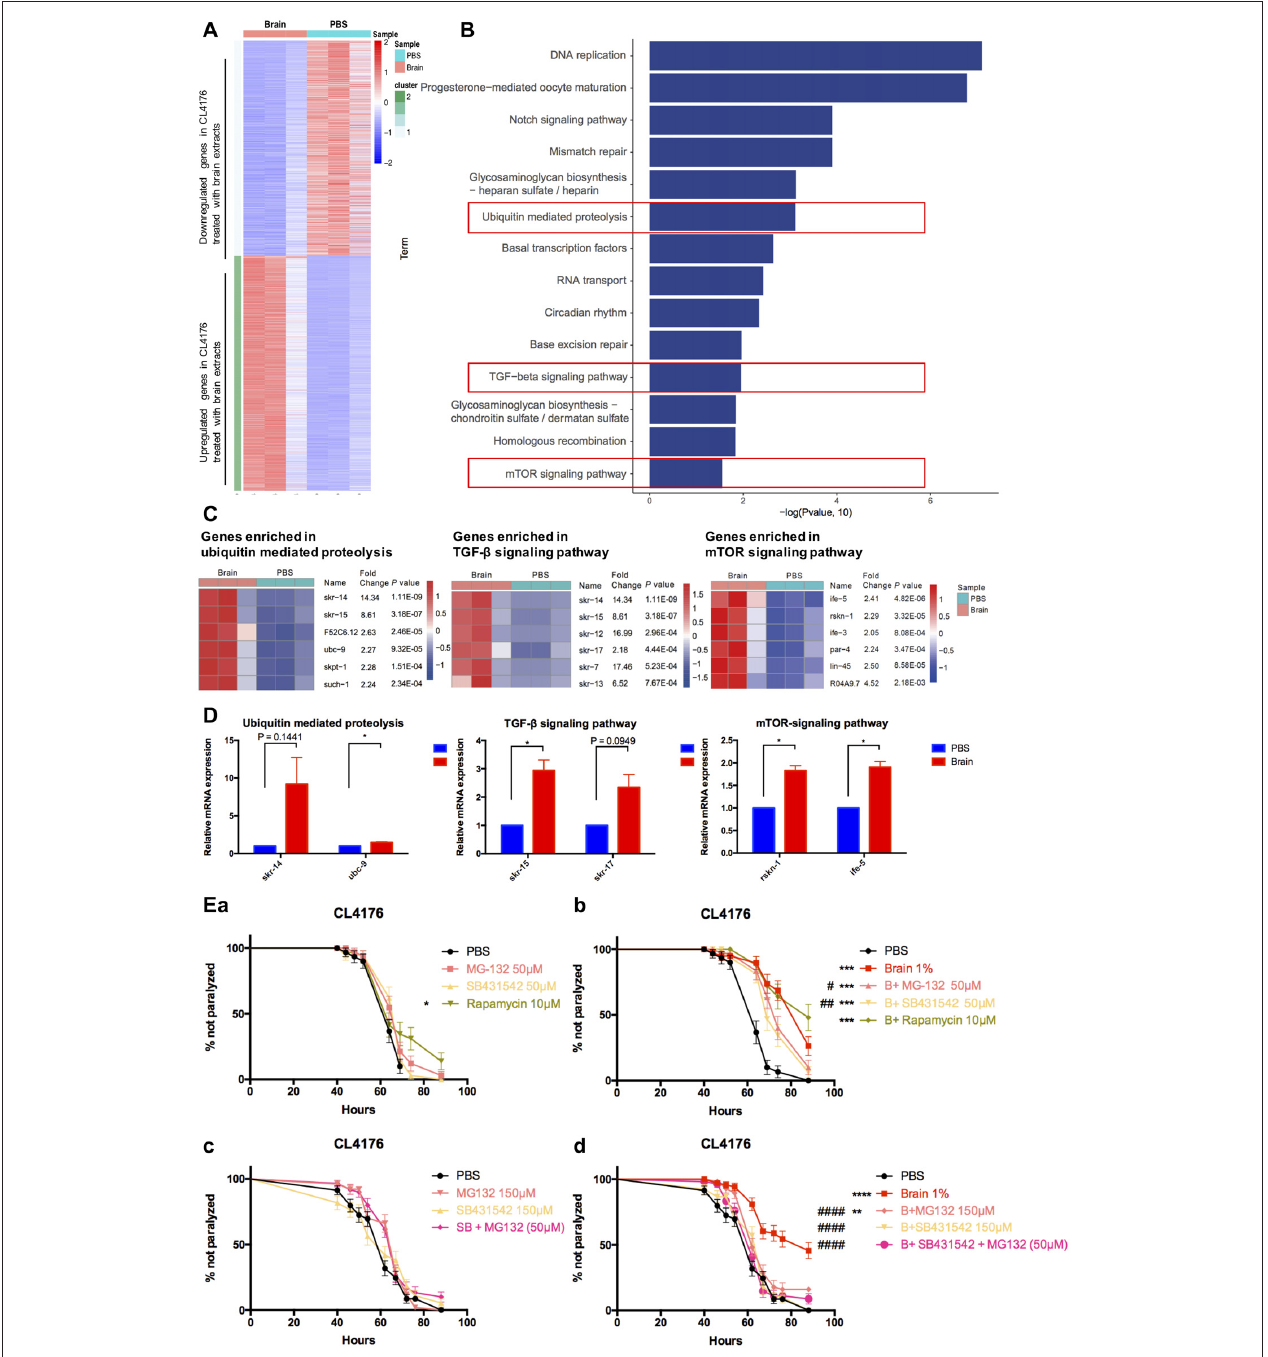
FIGURE 4 | Multiple pathways were involved in the suppressive effects of brain extracts on worm paralysis. (A) The heat map of total dysregulated genes in brain extracts-treated CLL4176 worms ( P < 0.01, fold change ≥ 2). (B) KEGG pathway analysis of genes significantly upregulated in CL4176 treated with brain extracts ( P < 0.05). (C) The heat map showing upregulation of genes that were involved in three KEGG pathways: ubiquitin mediated proteolysis, TGF- β signaling pathway and mammalian target of rapamycin (mTOR) signaling pathway. (D) The mRNA expression levels of skr-14 , ubc-9 , skr-15 , skr-17 , rskn-1 , ife-5 , components of the above KEGG pathways, were verified by real time polymerase chain reaction (RT-PCR) with worm collected from another three sets of independent experiments, ∗ P < 0.05, with unpaired t -test. (E) The effects of brain effects on worm paralysis under the intervention of inhibitors for the three upregulated pathways in CL4176 worms. (a) The effects of the inhibitors at low doses on CL4176 worms in Phosphate buffer saline (PBS). (b) The effect of brain extracts with the low doses of inhibitors. (c) The effects of the inhibitors at high doses on CL4176 worms in PBS. (d) The effect of brain extracts with high doses of inhibitors. MG-132: inhibitor of ubiquitin mediated proteolysis; SB431542: inhibitor of Transforming growth factor β (TGF- β ) signaling pathway: Rapamycin: inhibitor of mTOR signaling pathway. ∗ P < 0.05, ∗∗ P < 0.01, ∗∗∗ P < 0.001, ∗∗∗∗ P < 0.0001, compared with PBS group; # P < 0.05, ## P < 0.01, #### P < 0.0001, compared with Brain group.